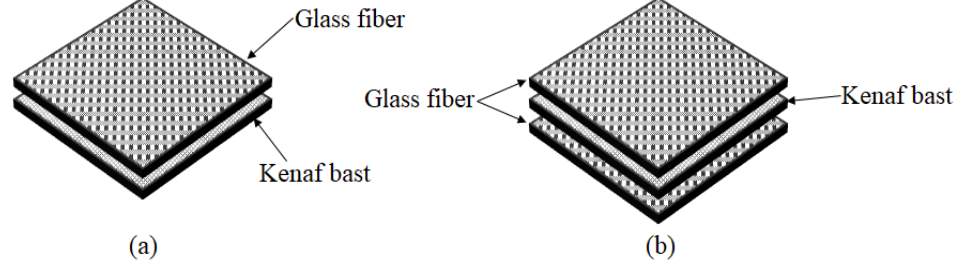
Figure 1. Fabrication method for KBF/GF hybrid composite; ( a ) KBF mat and GF mat; ( b ) placement of KBF at the stainless steel mold; ( c ) cold-pressed of the mold; ( d ) cured sample.